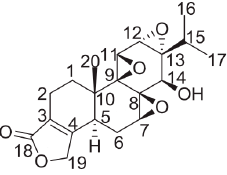
Figure 1. Chemical structure of (Triptolide)TP.